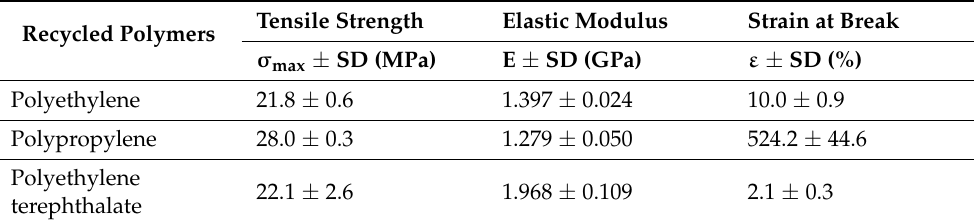
Table 3. Tensile strength, modulus, and strain at break of recycled PE, PP and PET. Recycled Polymers